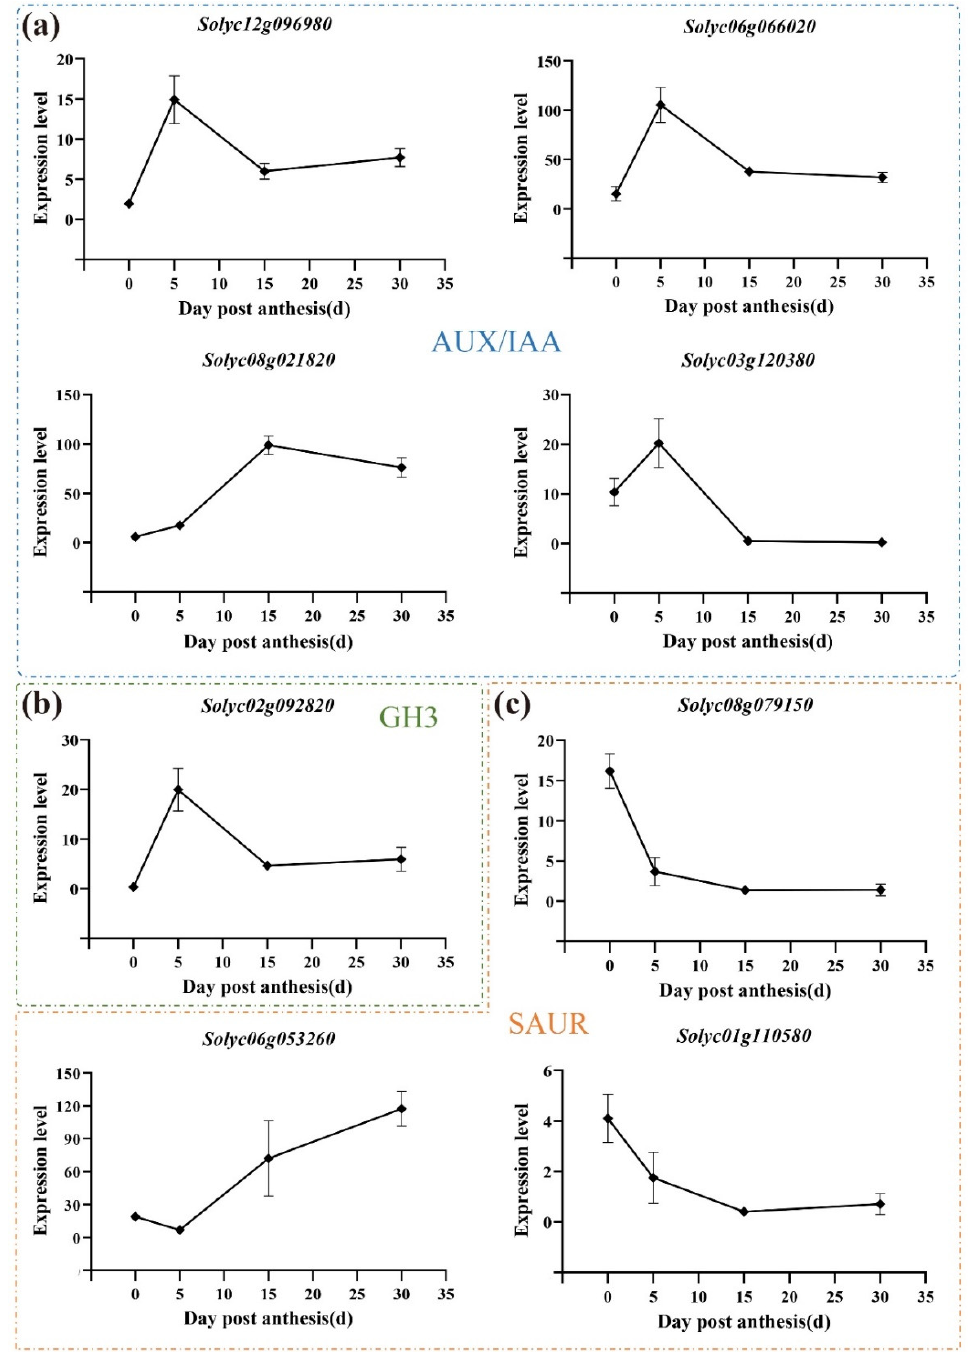
Figure 6. The expression levels of auxin-related genes at different developmental stages. ( a ) The blue box indicates the genes belonging to the AUX/IAA family. ( b ) The green box indicates the genes belonging to the GH3 family. ( c ) The orange box indicates the genes belonging to the SAUR family.